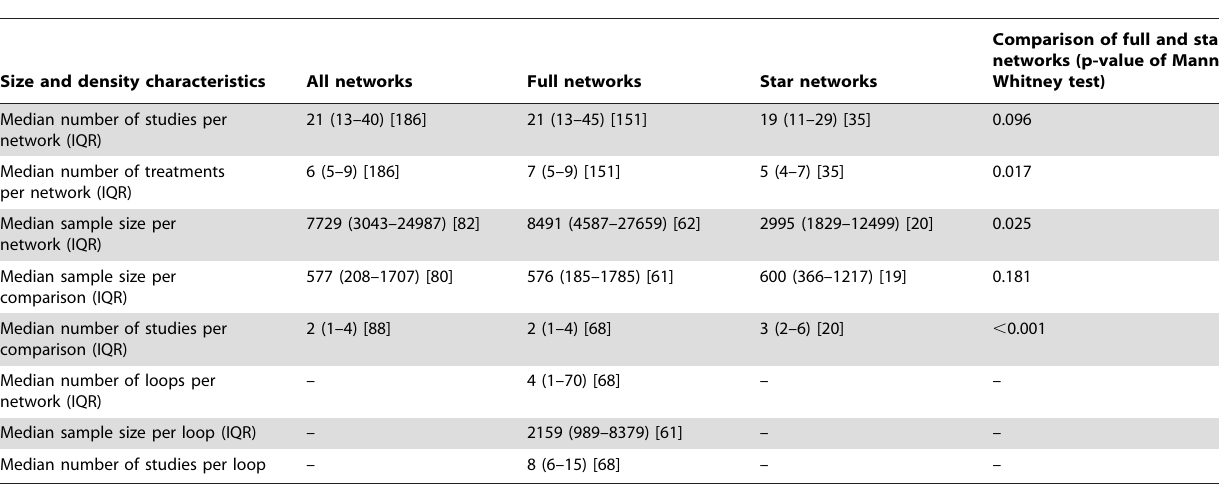
Table 3. Structural characteristics of full and star